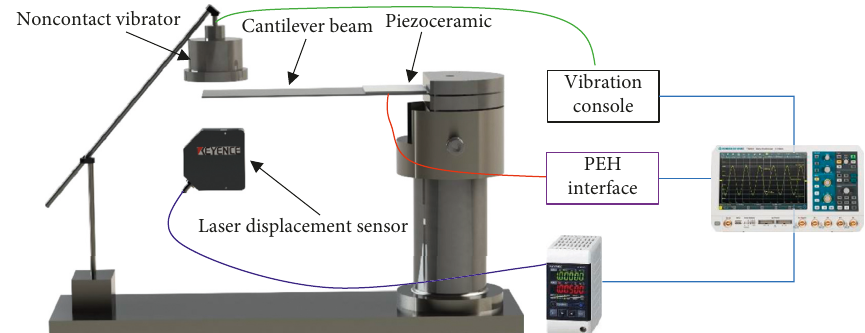
Figure 11: Vibration energy-harvesting experimental setup.